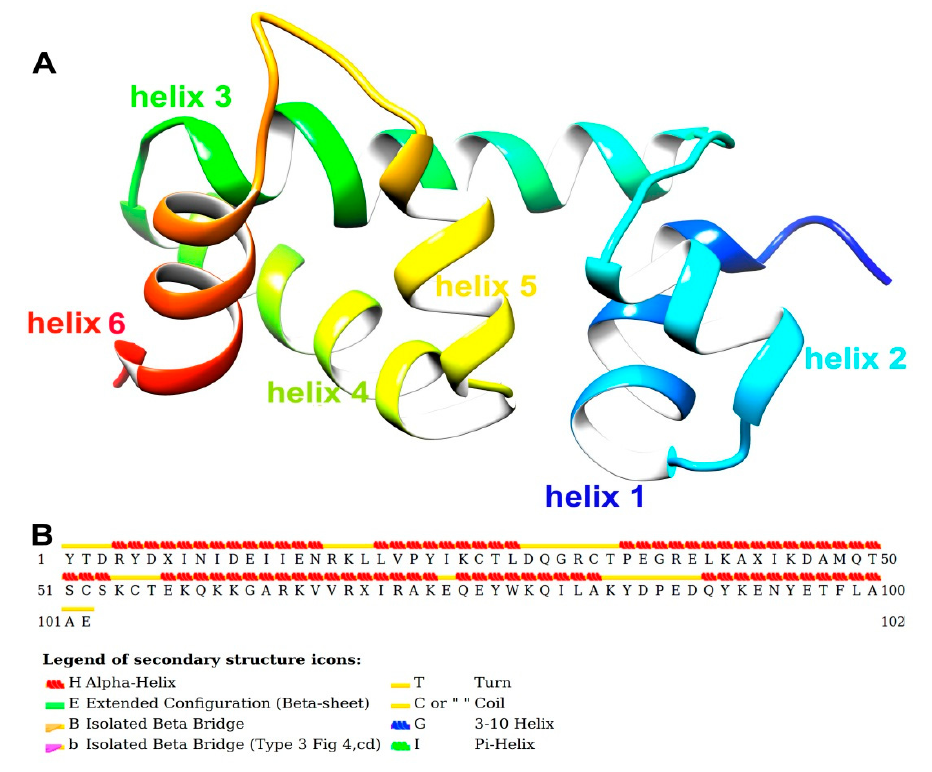
Figure 3. ( A ) Cartoon representation of native-like SlitCSP3 model chosen for further calculations. The structure is composed of six helices marked in different colors. ( B ) A graphical representation of STRIDE secondary structure calculation.